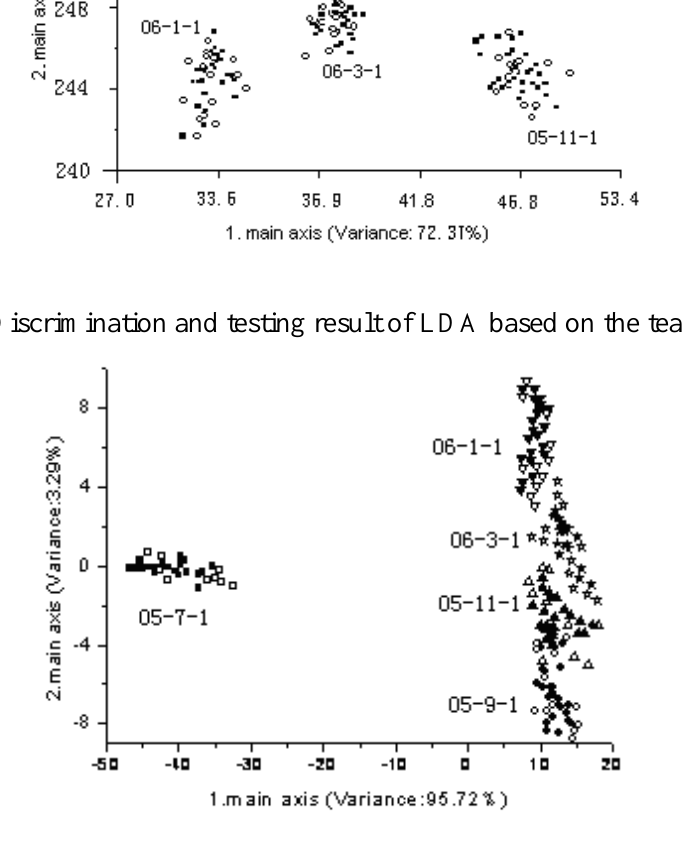
Figure 4. Discrimination and testing result of LDA based on the tea